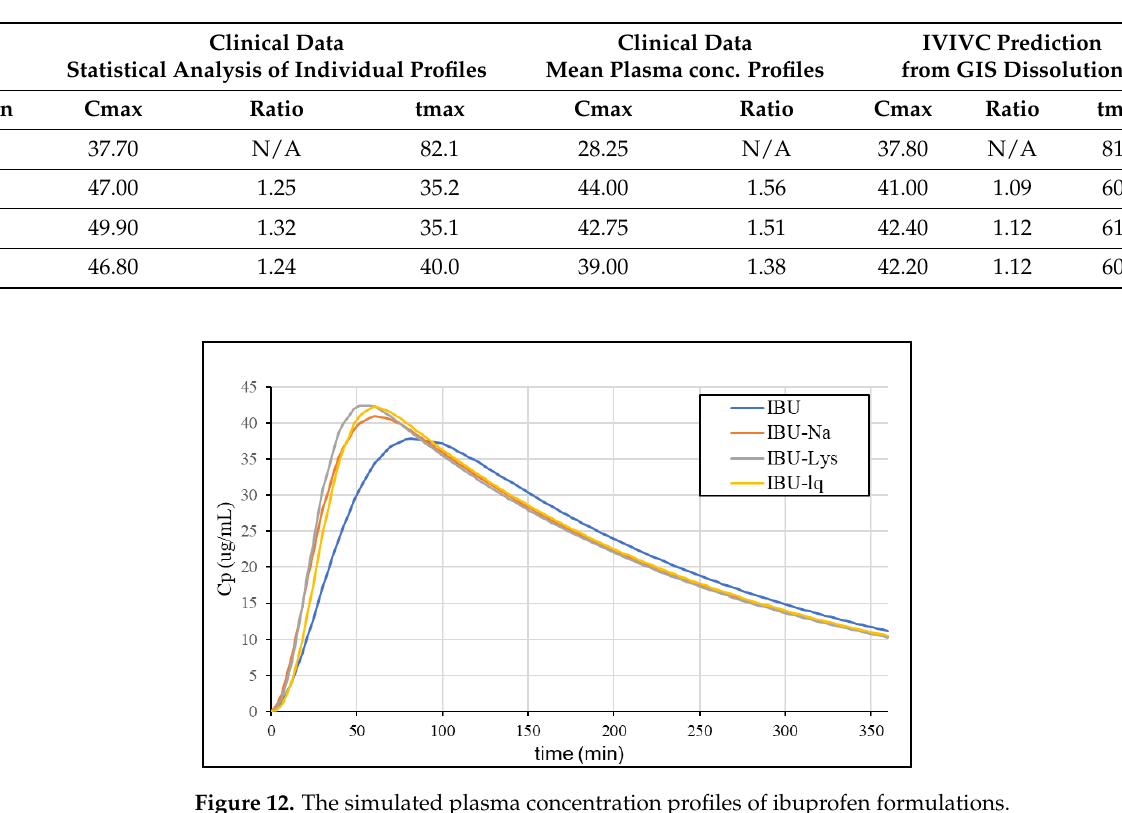
Table 6. Observed [23] vs. predicted pharmacokinetic data of ibuprofen formulations.